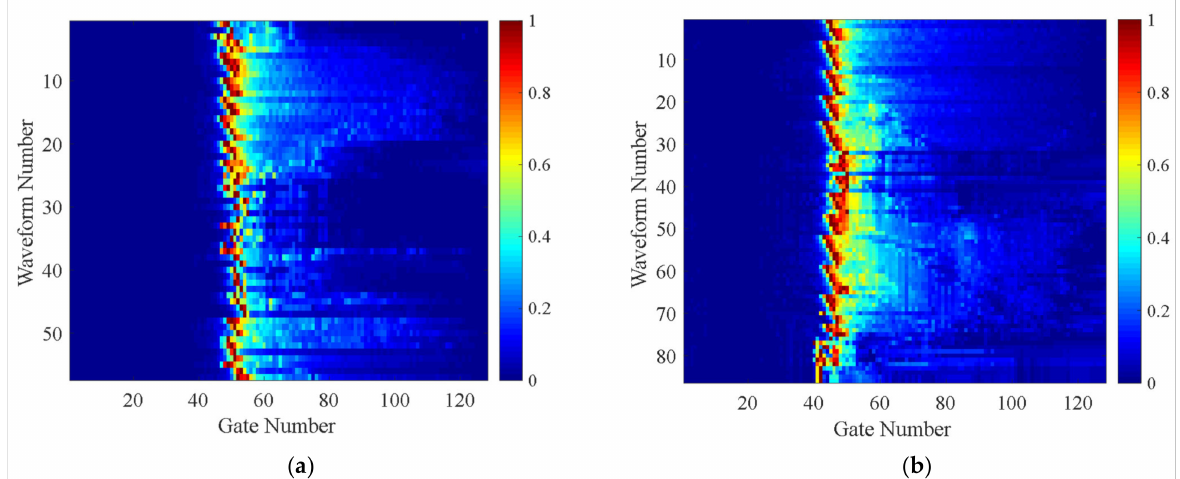
Figure 8. The reconstruction results corresponding to the waveforms in Figure 2b ( a ) and Figure 2d ( b